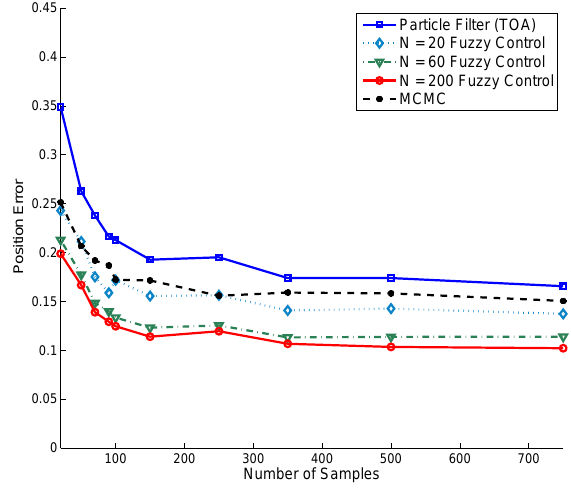
Figure 14. Performances of the MCMC scheme and the adaptive fuzzy control (using TOA information) with varying the number of iterative